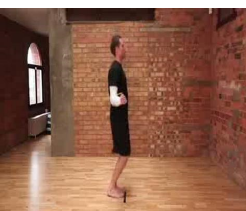
Figure 15. Sample video frames of Action 7 (jump rope).